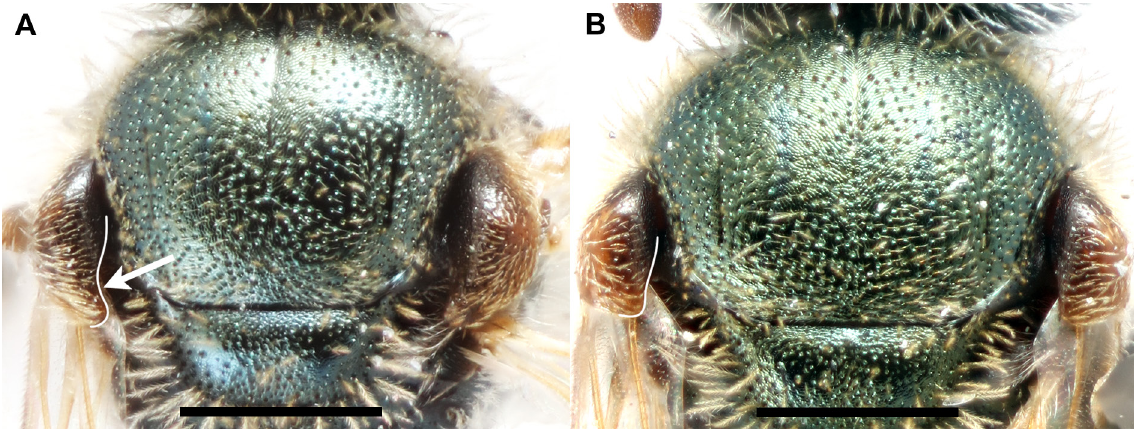
Fig. 87. Tegulae. A . Lasioglossum angelicum sp. nov., ♀, large with inner posterior margin concave and distinct posterior projection (outline and arrow). B . L. diabolicum sp. nov., ♀, small with inner posterior margin nearly straight and no posterior projection (outline). Scale bars = 0.5 mm.